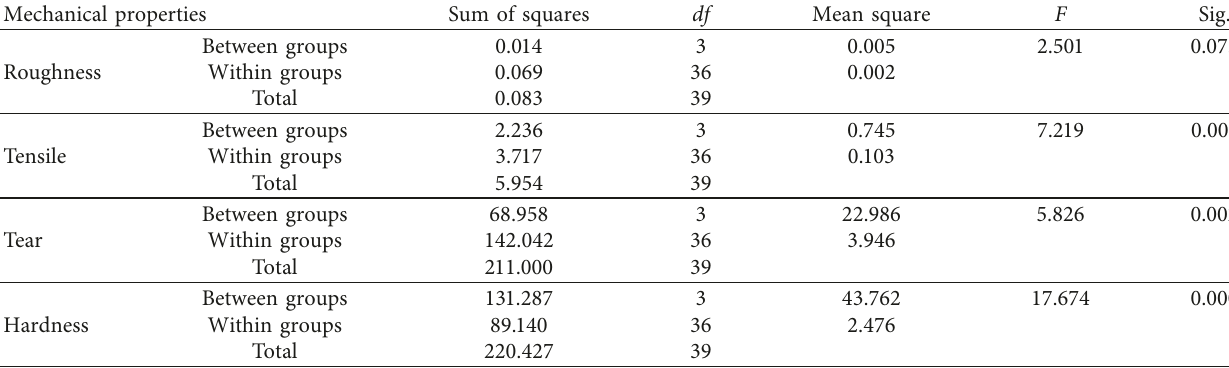
Table 2: One-way ANOVA showing significant difference between all tested groups.